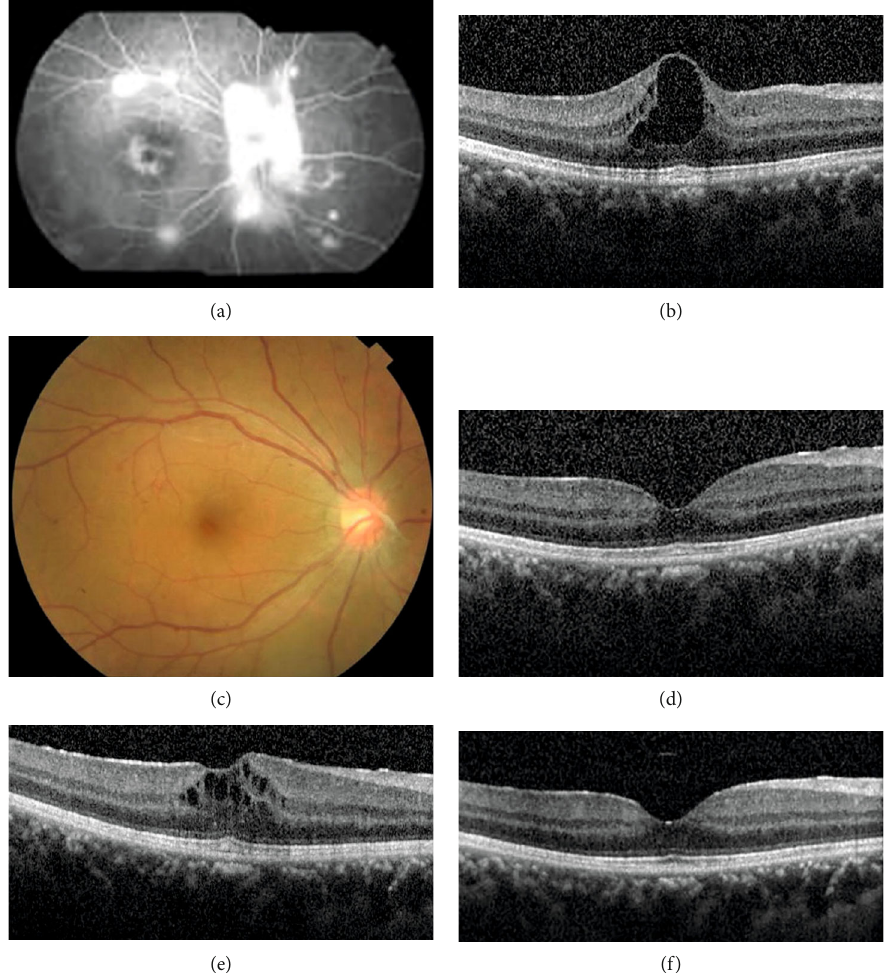
Figure 2: (a) FA showed vascular tortuosity, peripheral retinal NV, and ME. (b) Persistent ME after periocular depot triamcinolone acetonide injection (central foveal thickness 538 μ m). (c) After the fi rst intravitreal a fl ibercept injection, the retinal NV regressed. (d) ME also subsided (central foveal thickness 309 μ m). (e) ME recurred after 3 months (central foveal thickness 438 μ m). (f) Intravitreal a fl ibercept injections had to be performed every three months to keep macula free from edema (central foveal thickness 295 μ